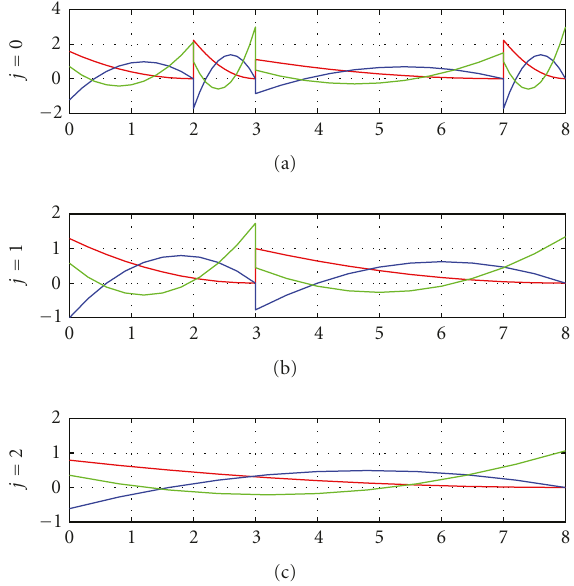
Figure 4: Quadratic scaling functions at resolutions j =